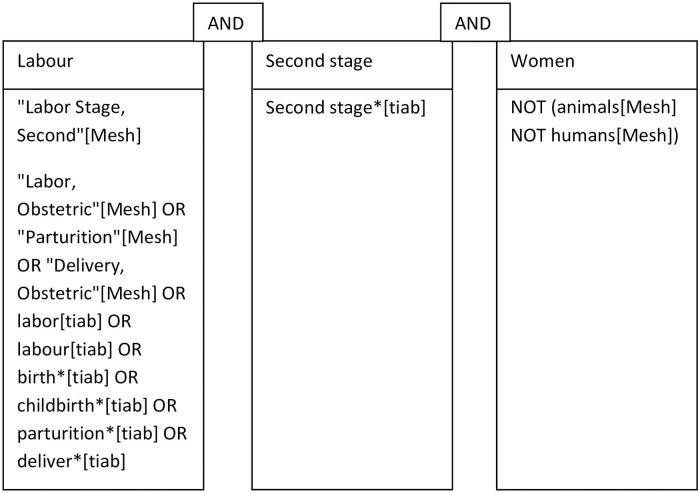
Search strategy.